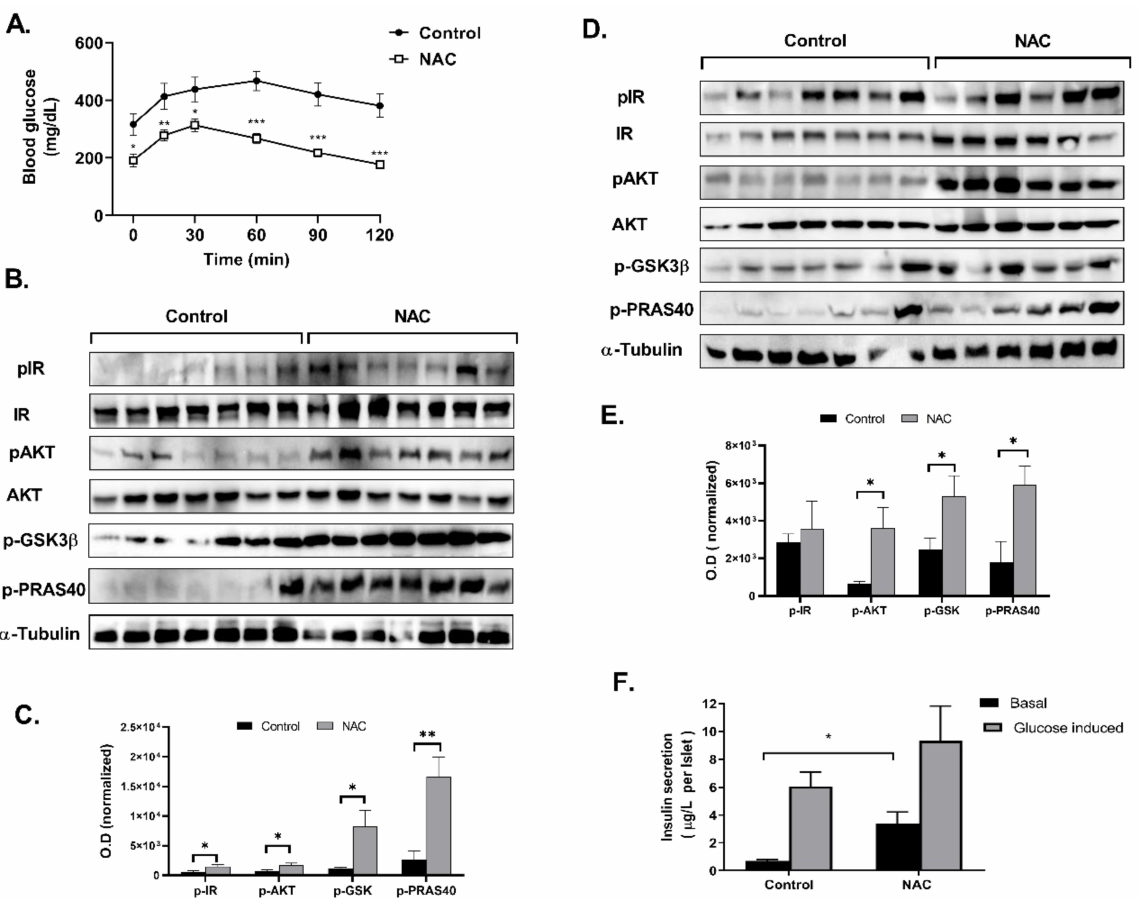
Figure 10. NAC improved glycemic control in diabetic KK-Ay mice. Mice ( n = 10, 6 weeks old) were given NAC (1200 mg/kg/day) for 9 weeks, as described in Methods. ( A ) GTT was performed at the age of 15 weeks as described in Methods ( n = 7). Western blot analysis and densitometry analysis of proteins involved in insulin signaling pathway was performed in muscle ( B , C ) and liver ( D , E ). Optical density was normalized to the non-phosphorylated form or to housekeeping protein. ( F ) Pancreatic islets were isolated, and GSIS was performed as described in Methods. The results are presented as the mean ± SEM. * p < 0.05, ** p < 0.005 and *** p < 0.0005 by one-way Anova